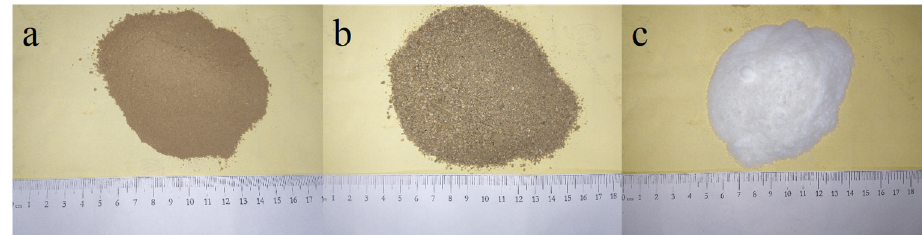
Figure 2. The ( a ) clayey soil, ( b ) sandy soil, and ( c ) nano-SiO 2 used in this study.